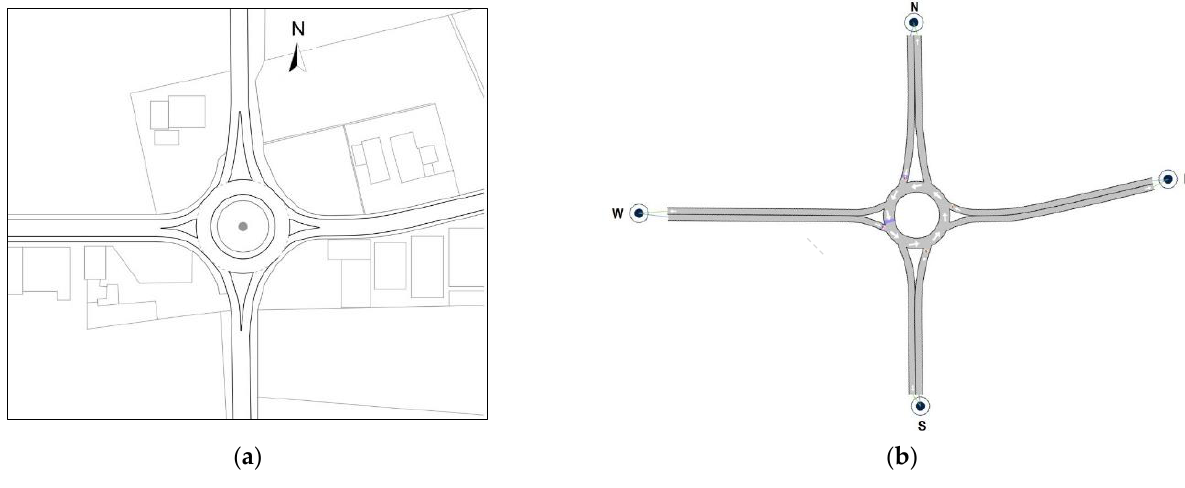
Figure 3. The single-lane roundabout (roundabout 1): ( a ) the sketch of the roundabout; ( b ) the network model built in Aimsun Next with labels for the centroids (N: North; S: South; E: East; W: West). The single-lane roundabout in Figure 3a is located in western Sicily, Italy, at the in-